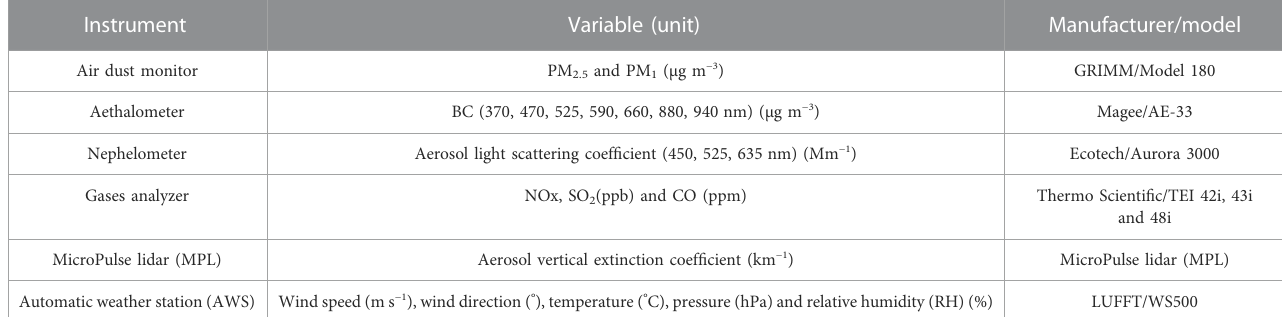
TABLE 1 Instruments for measurements at the Chenggong station.